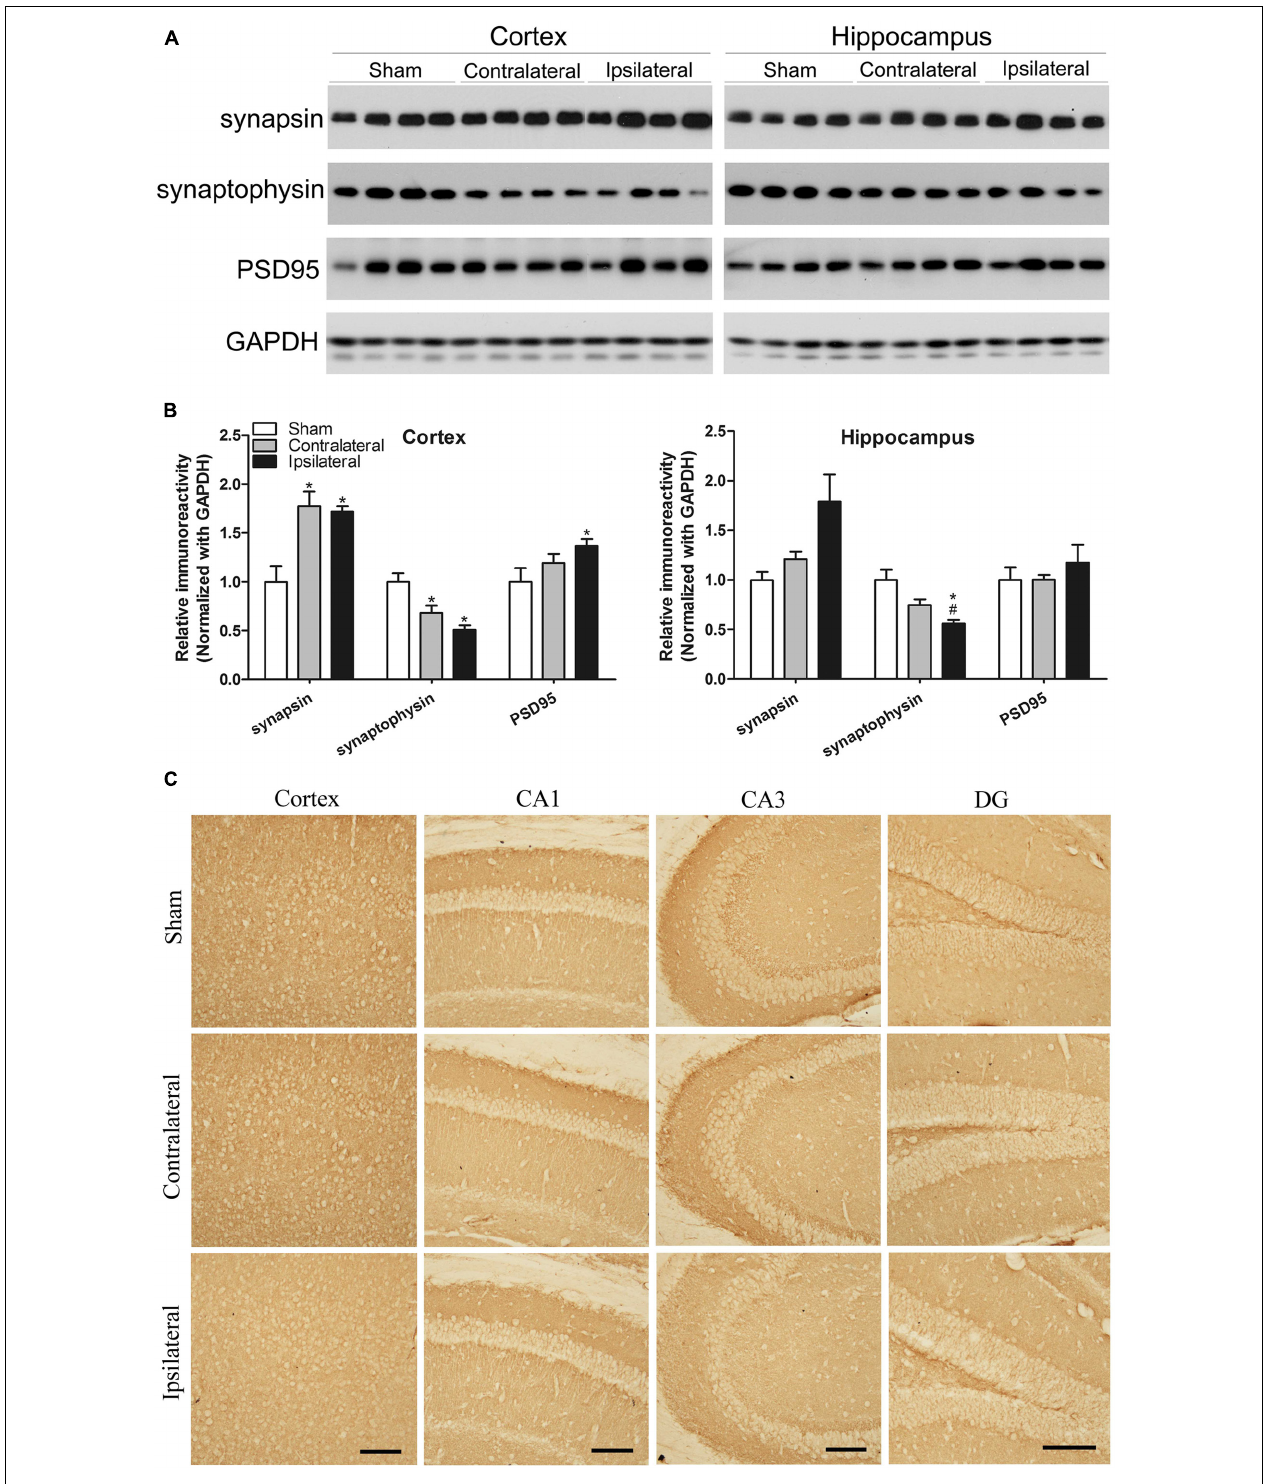
FIGURE 5 | Effects of CCH on synaptic proteins. Homogenates of the cortices and hippocampi of mice 2.5 months after sham or UCCAO surgery were analyzed by Western blots developed with the indicated antibodies (A) . The blots were then quantified densitometrically, and the data after normalization with the GAPDH level are presented as